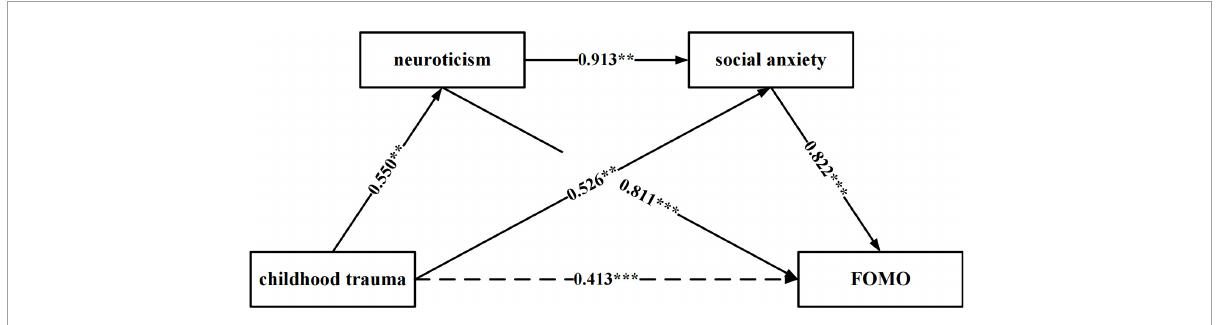
FIGURE1 The multiple mediation model. The link between childhood trauma and FOMO is mediated by neuroticism and social anxiety. Path values are the path coefficients. ** p < 0.01; *** p < 0.001.